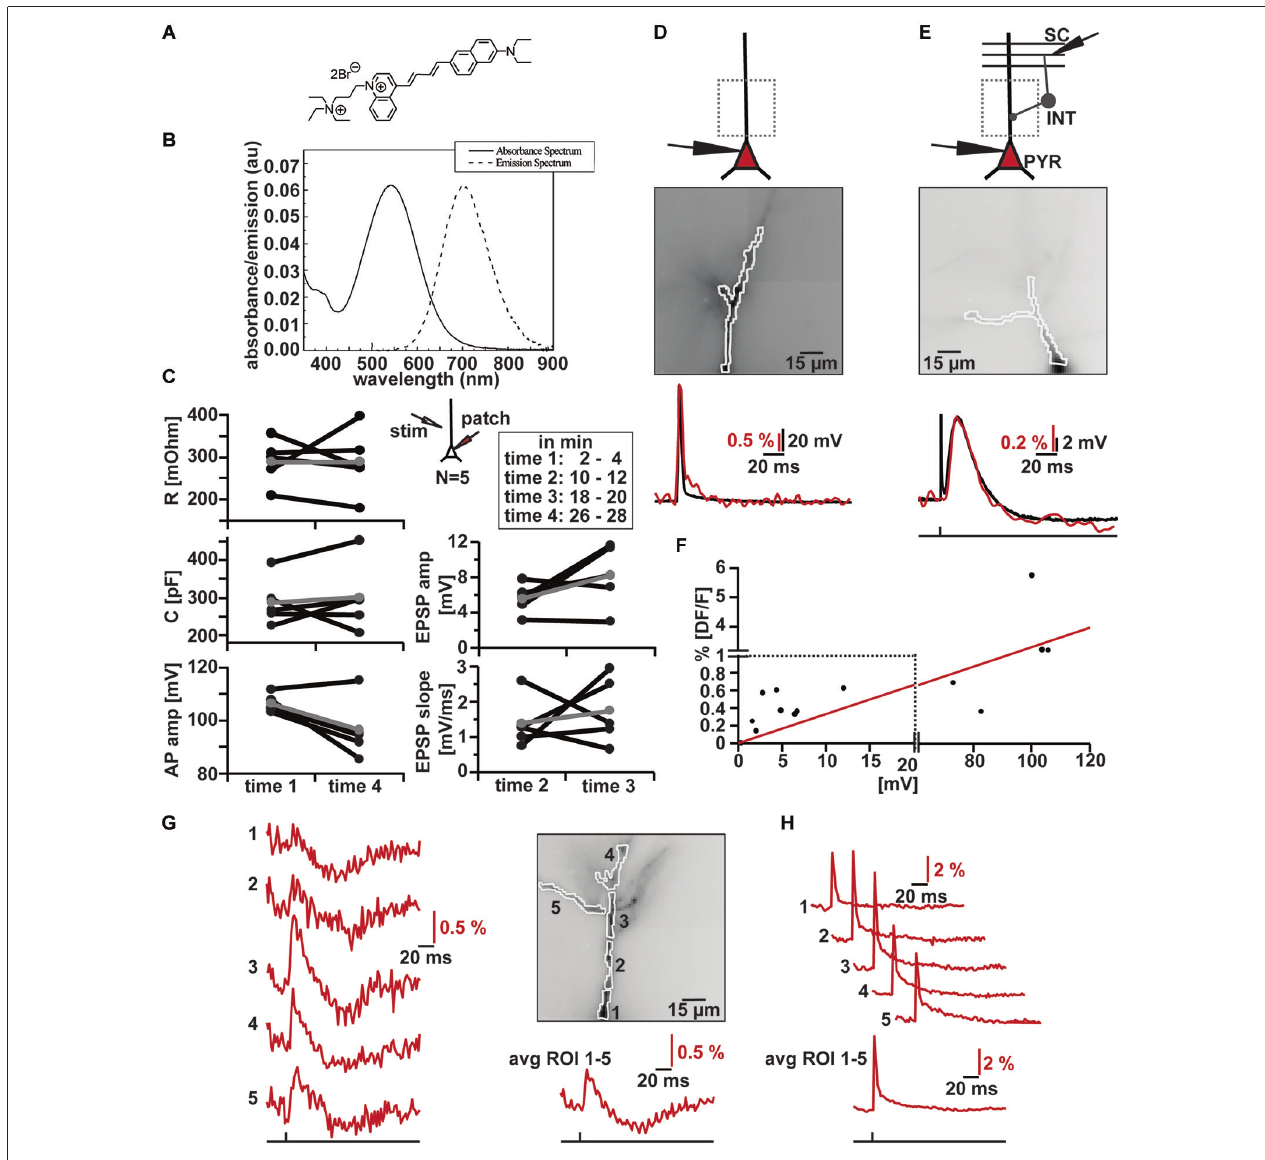
optical dendritic (red trace, DF/F = 3.2%, average of 2 trials) and electrical somatic (black trace, ∆ V = 103.6 mV; Vm = − 59.9 mV) recording. (E) Simultaneous optical and electrical EPSP/IPSP recording in CA1 pyramidal cell induced by SC stimulation. Top: Schematic illustration of patched cell, imaging region and stimulation site. Middle: Image of filled apical dendrite with highlighted region of interest ( (cid:80) = 121 pixels). Bottom: Simultaneous optical dendritic (red trace, DF/F (EPSP) = 0.6%, DF/F (IPSP) = 0.2%, average of 6 trials) and electrical somatic (black trace, ∆ V (EPSP) = 12 mV, ∆ V (IPSP) = 1.7 mV; Vm = − 67 mV) recording. (F) DF/F vs. Vm correlation plot (taken from data of 10 cells) and the linear fit to this data (red). Note change in scaling on x- and y-axis. (G) High resolution optical recording after SC stimulation. Left: optical dendritic recordings of EPSP-IPSP patterns in the marked ROIs (1–5; average of 4 trials). Right top: Image of filled apical dendrite with highlighted ROIs. Right bottom: Optical recording over whole dendrite ( (cid:80) = 290 pixels). (H) Optical dendritic recordings of intracellularly induced action potential in the marked regions of interest (ROI) in same cell as in (G) (1–5; average of 10 trials). Bottom: Optical recording over whole dendrite ( (cid:80) = 290